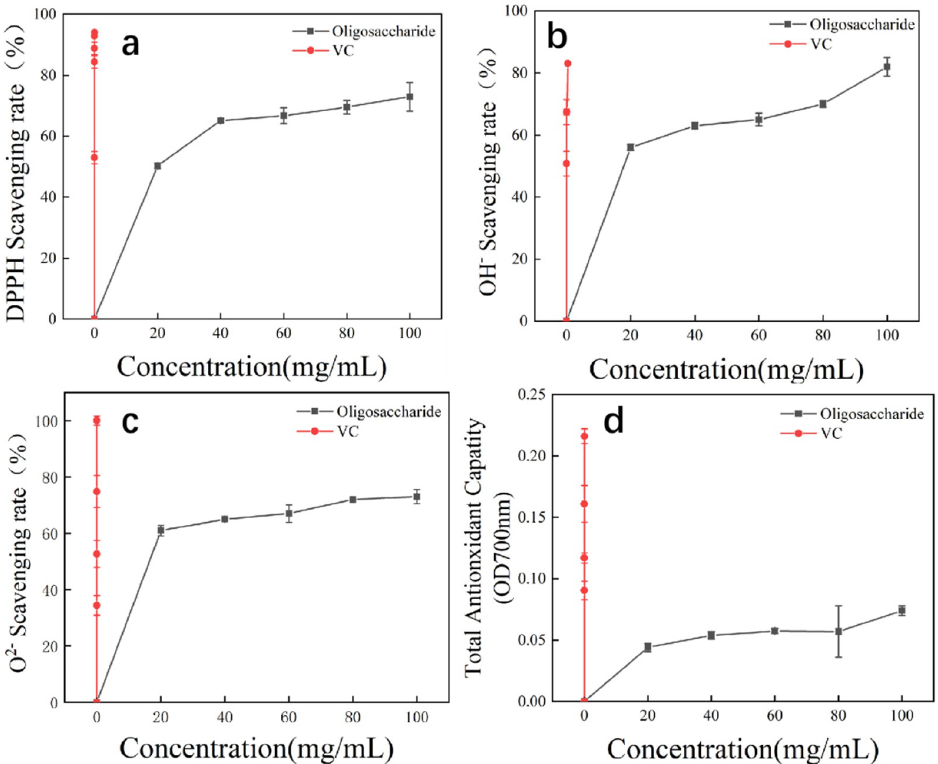
Figure 5. Antioxidant activity analysis of hydrolysis products of PsDex1711. The red line is the amount of VC added. ( a ) DPPH scavenging rate; ( b ) Hydroxyl radical scavenging activity; ( c ) Superoxide anion clearance rate; ( d ) Antioxidant capacity .